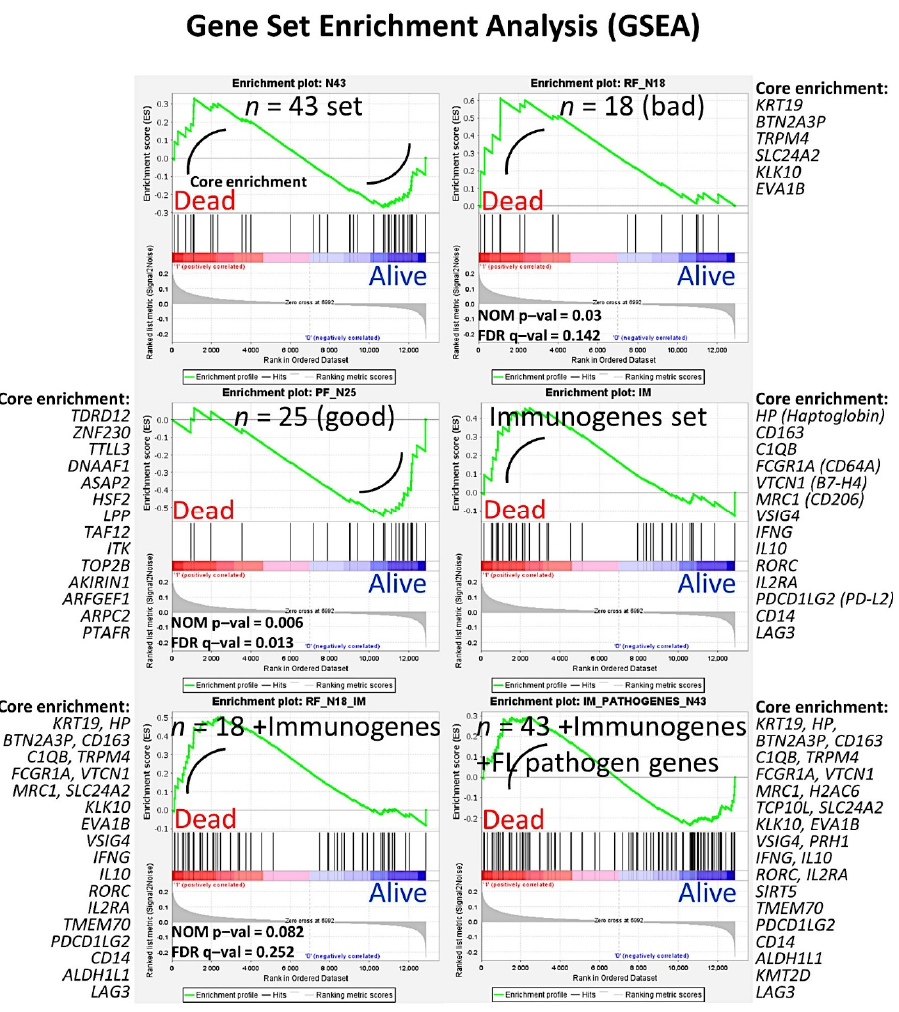
Figure 6. Prediction of the overall survival of follicular lymphoma using an algorithm based on neural networks. This figure shows the GSEA results of Figure 4 in detail. Gene set enrichment analysis (GSEA) was performed to confirm the results of the multivariate Cox regression for the overall survival analysis. The set of 43 was used in addition to genes of the immune response as well as oncogenes and tumor suppressor genes related to the pathogenesis of follicular lymphoma. Of note, genes related to macrophages were highlighted, such as CD163 . NOM p–val, nominal p value (the nominal p value estimates the statistical significance of the enrichment score for a single gene set); FDR q–val, false discovery rate.